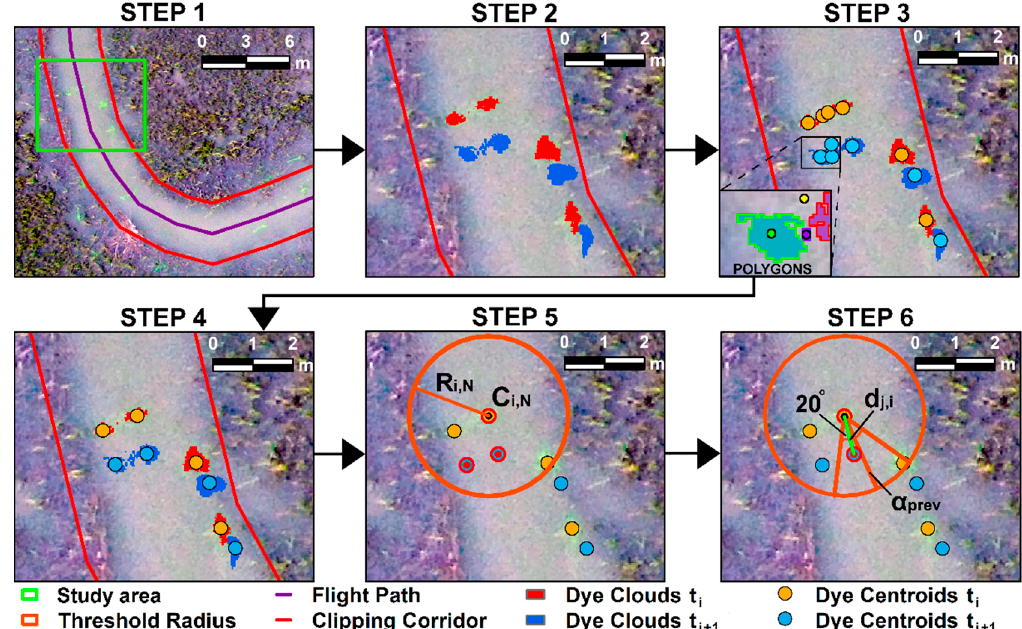
Figure 6. Dye analysis workflow. ( STEP 1 ) A corridor to use for the dye detection is created by o ff setting the flight path followed by the UAV; ( STEP 2 ) dye clouds are identified in the clipped images, using a classification algorithm; ( STEP 3 ) detected clouds are converted in polygons, of which area and centroid are calculated; ( STEP 4 ) centroid associated with areas smaller than 0.01 m 2 or larger than 1 m 2 are removed from the analysis; ( STEP 5 ) given the i th dye cloud in the N th image, having C i,N as center (red circle and black center dots), the possible candidates describing the same cloud in the (N + 1) th image are the clouds having their barycenter inside a circle of radius R i,N and centered in C i,N (red circle and center dots); ( STEP 6 ) the correct cloud (red circle and center dot) is selected considering the angle α j , i of the displacement vector d j , i connecting the i th barycenter in the N th and (N + 1) th images, and an angle of ±20° from this direction.